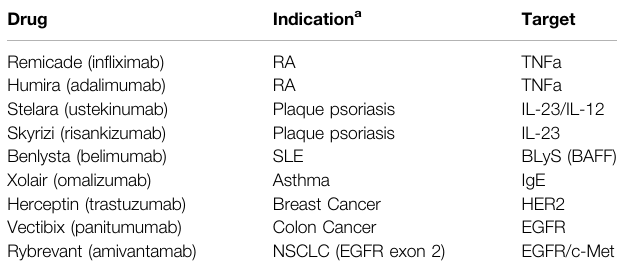
TABLE 1 | Biotherapeutics included in EFA analysis. Drug Indication